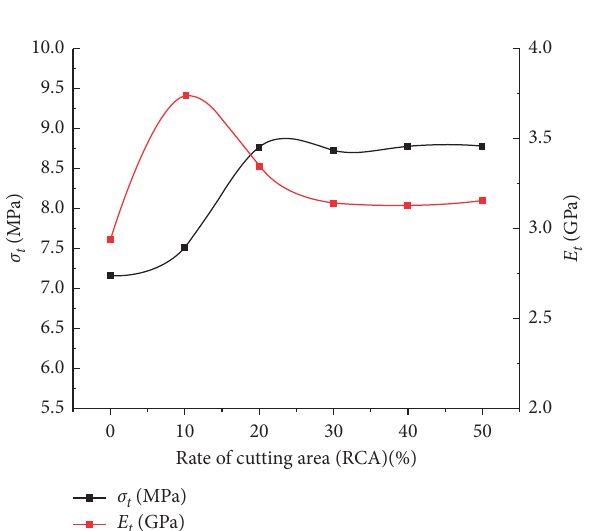
Figure 9: Illustration of the RCA.